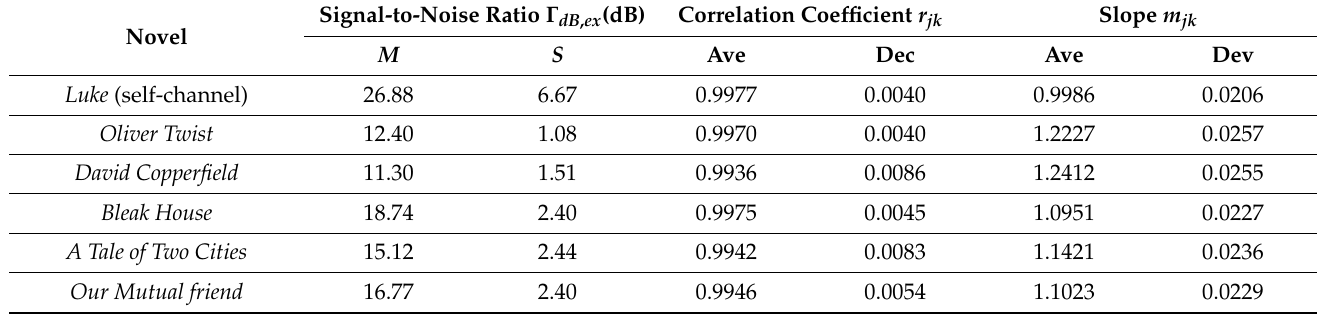
Table A3. Average value M (dB) and standard deviation S (dB) of Γ dB , ex (dB) in self- and cross- channels, correlation coefficient r jk , and slope m jk of the regression line between the number of sentences n S of John (channel output, self-channel) versus the number of sentences n S in Dickens’ novels (channel input cross-channels), for equal number of words, in the sentences